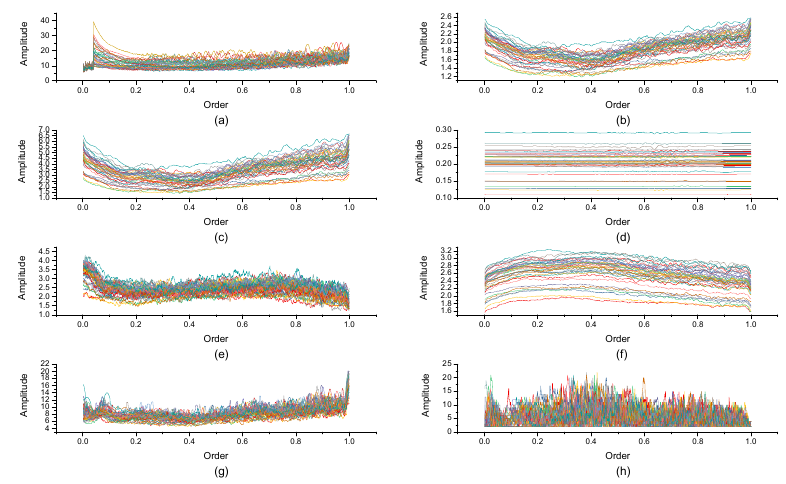
Figure 4. The Order–Amplitude figures of different features of 40 groups for the walk action. ( a ) range , ( b ) std , ( c ) var , ( d ) rms , ( e ) IQR , ( f ) mean , ( g ) pksMean and ( h ) pksNum . Figure 5. Standard deviation and mean of eight features of the walk action. ( a ) The standard deviation of each feature, ( b ) The mean of each feature. Table 2. Mean and min of standard deviation of each feature of walk.